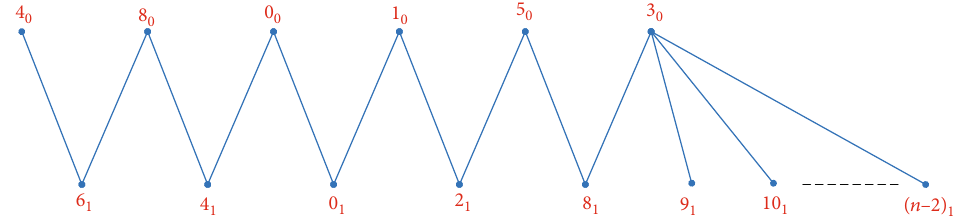
ð 1, 0, 0, 0, 0, 0, 0, 0, n − 9 Þ . 9